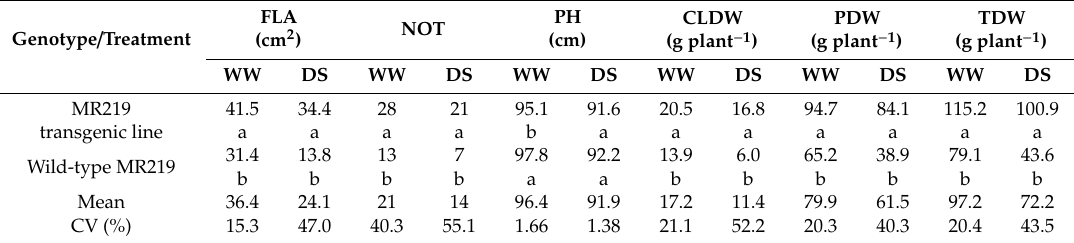
Table 3. The morphological traits performance of the rice genotypes under well-watered (WW) and drought stress (DS)